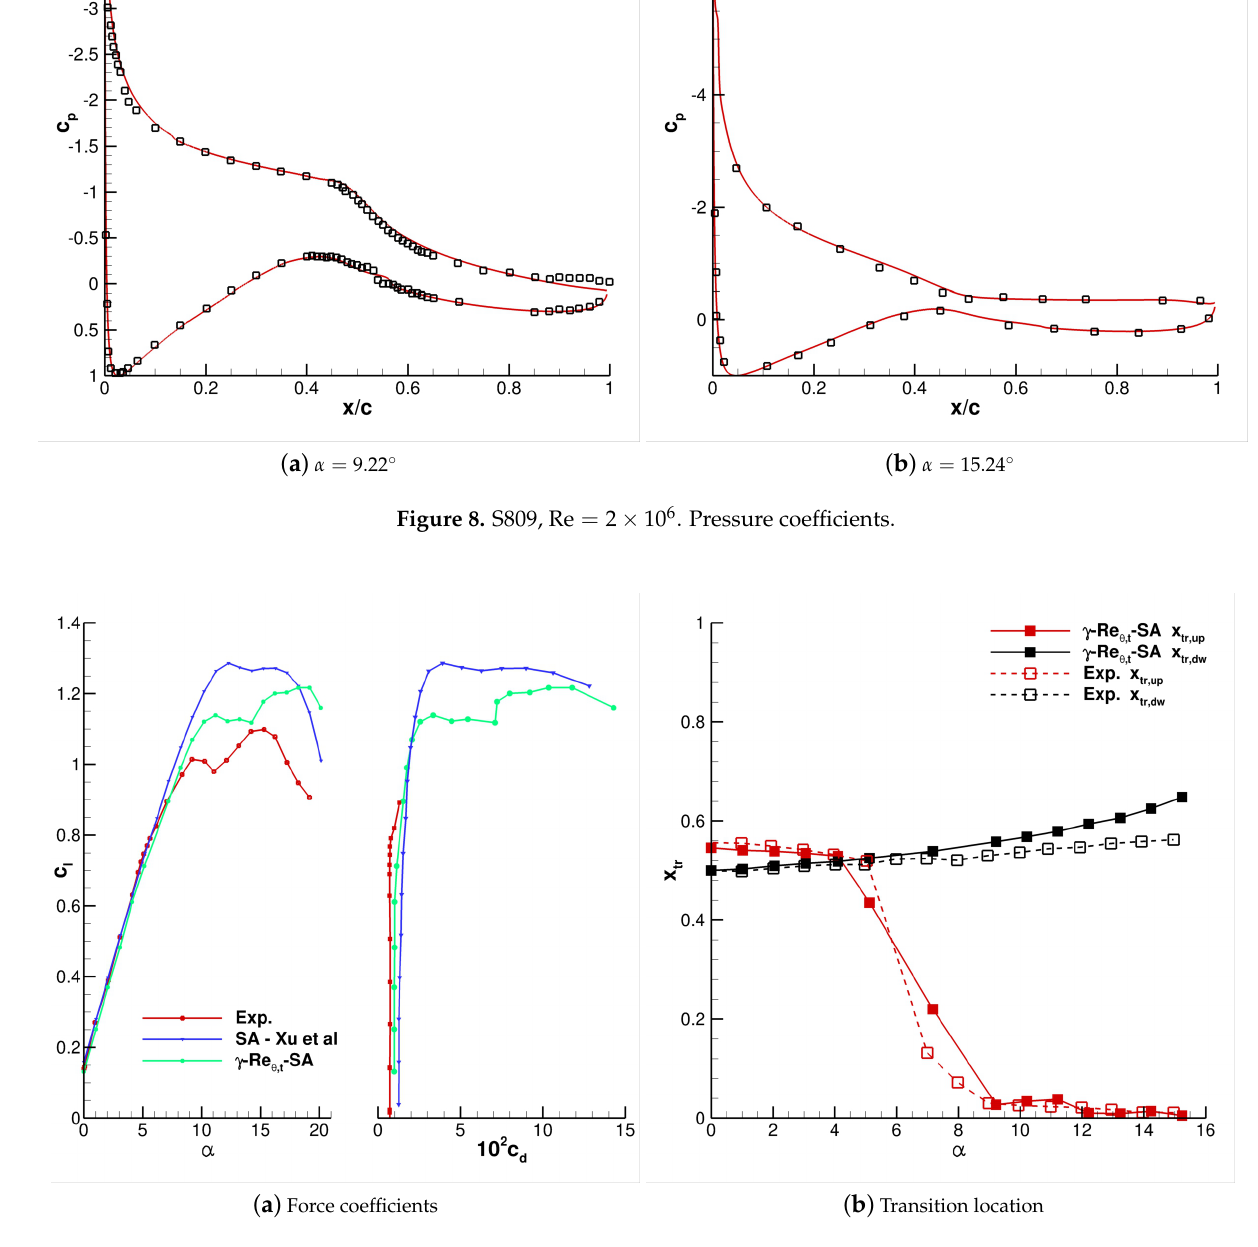
Figure 9. S809, Re = 2 × 10 6